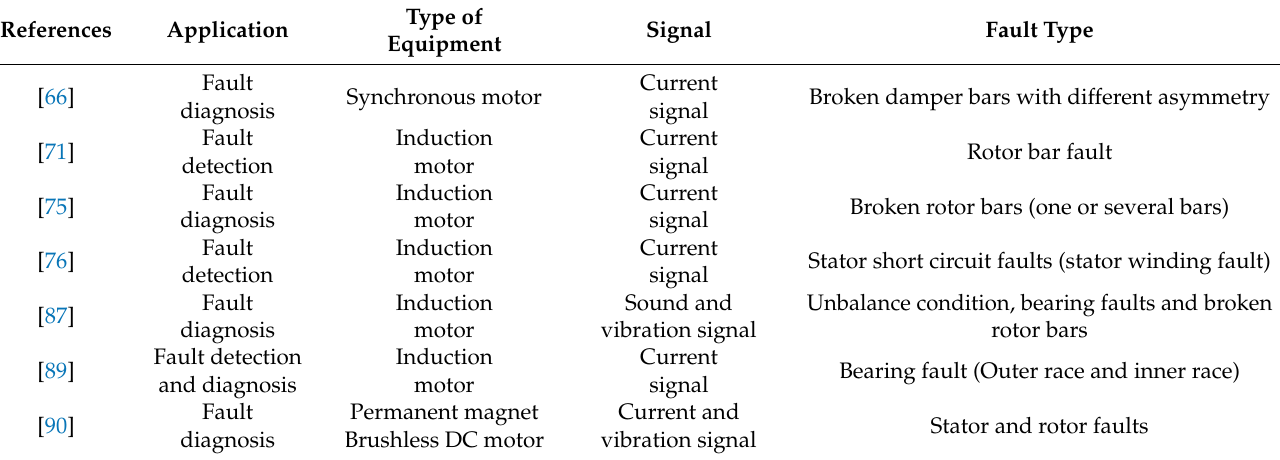
Table 7. Motor condition monitoring using empirical model decomposition.